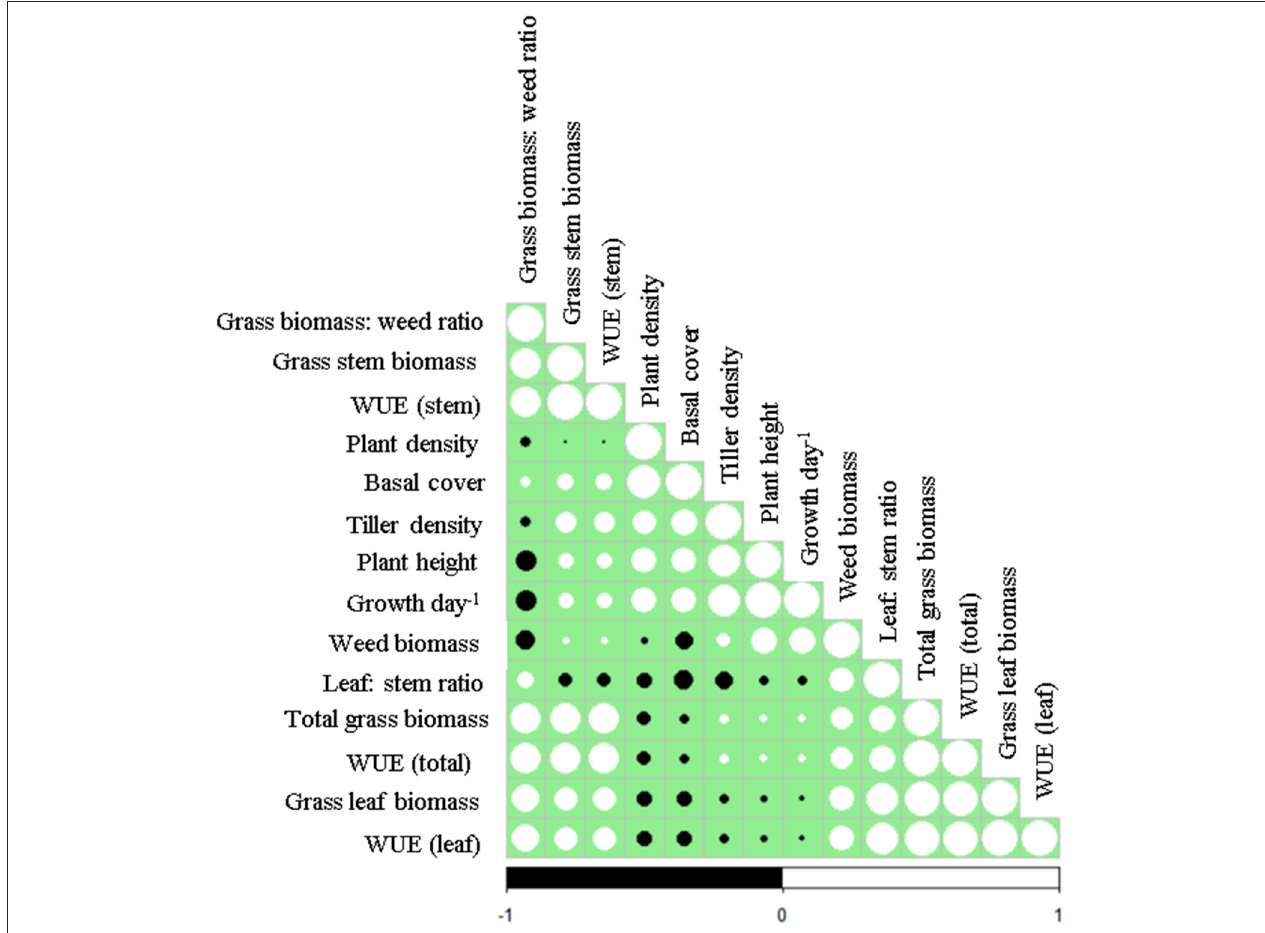
FIGURE 3 | Correlogram of plant morphoecological traits of selected perennial grasses indigenous to African rangelands. Positive correlations are displayed in white and negative correlations in black colored circles. The size of the circles are proportional to the correlation